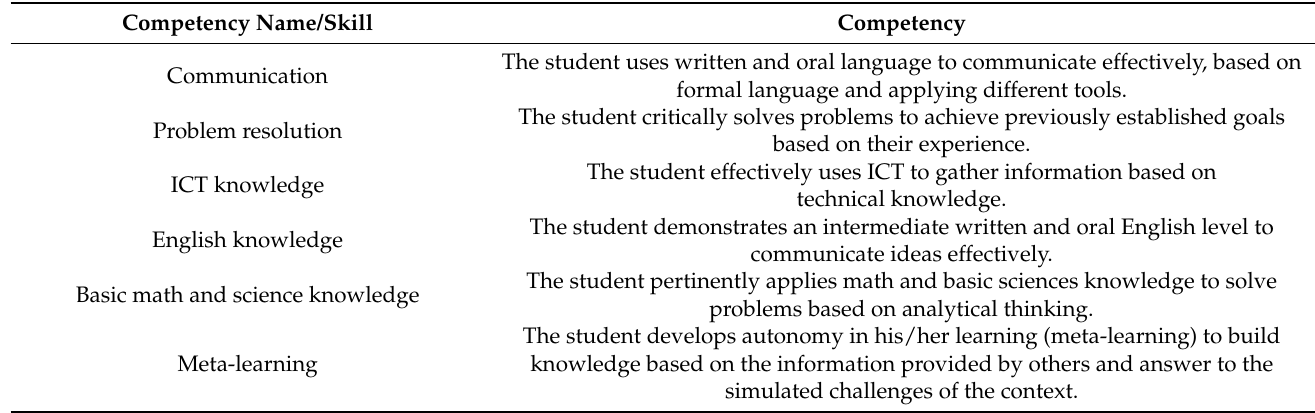
Table 6. Formulated competencies for the civil engineering admission